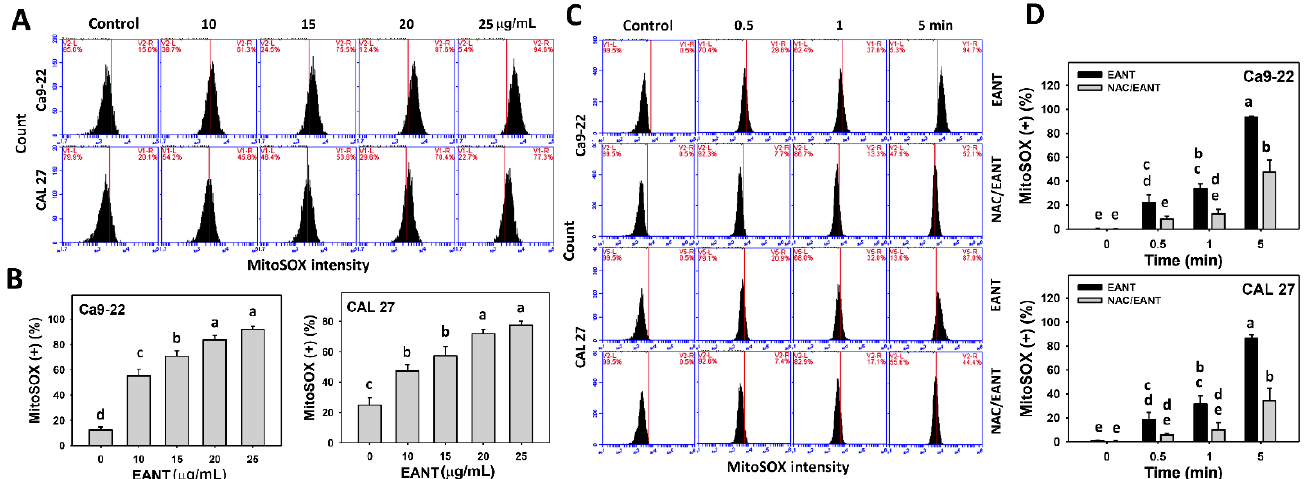
Figure 6. MitoSOX analysis. ( A , B ) MitoSOX patterns and statistical analysis for EANT treated oral cancer cells (CAL 27 and Ca9-22) for 5 min. ( C , D ) NAC (2 mM) pretreatment outcome to MitoSOX patterns and statistical analysis in EANT treatments (0 and 25 μg/mL) for 0, 0.5, 1, and 5 min. Data (mean ± SD, n = 3) showing different letters on-top differ significantly for multiple comparisons ( p < 0.05).